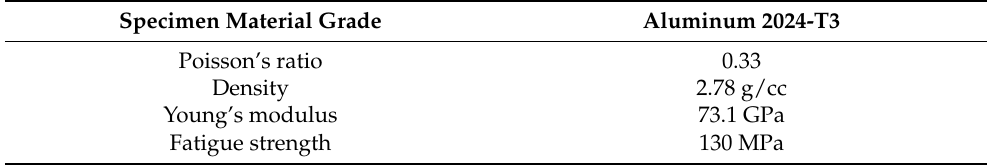
Table 1. Material properties of